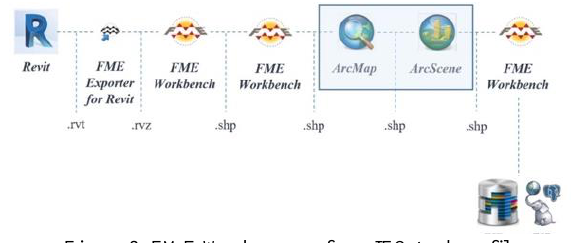
Figure 8. FME Workspaces: from IFC to shapefile.